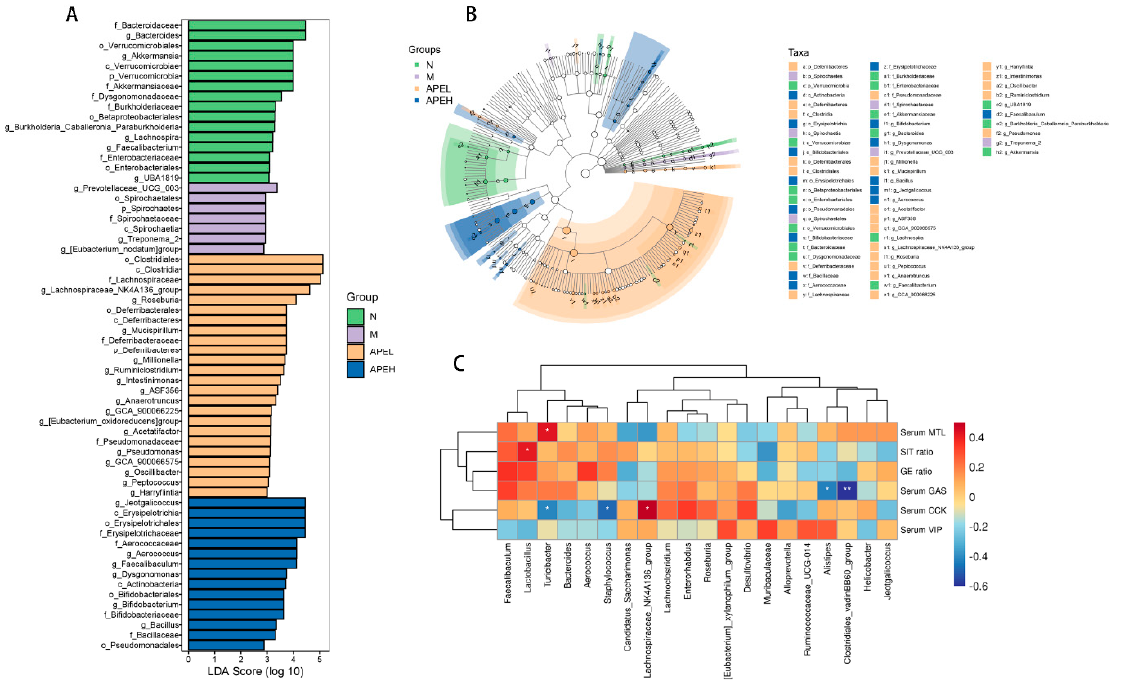
Figure 6. Microbial taxa discrepancies among normal, model, and APE groups (LDA scores of >2.0 and adjusted p values of <0.05). ( A ) Histogram and ( B ) cladogram. ( C ) Correlation analysis ( p value of <0.05 and |R2| of >0.7) based on Spearman’s rank-order correlation between the top 20 abundant gut microorganisms at the genera level and biochemical criterion.